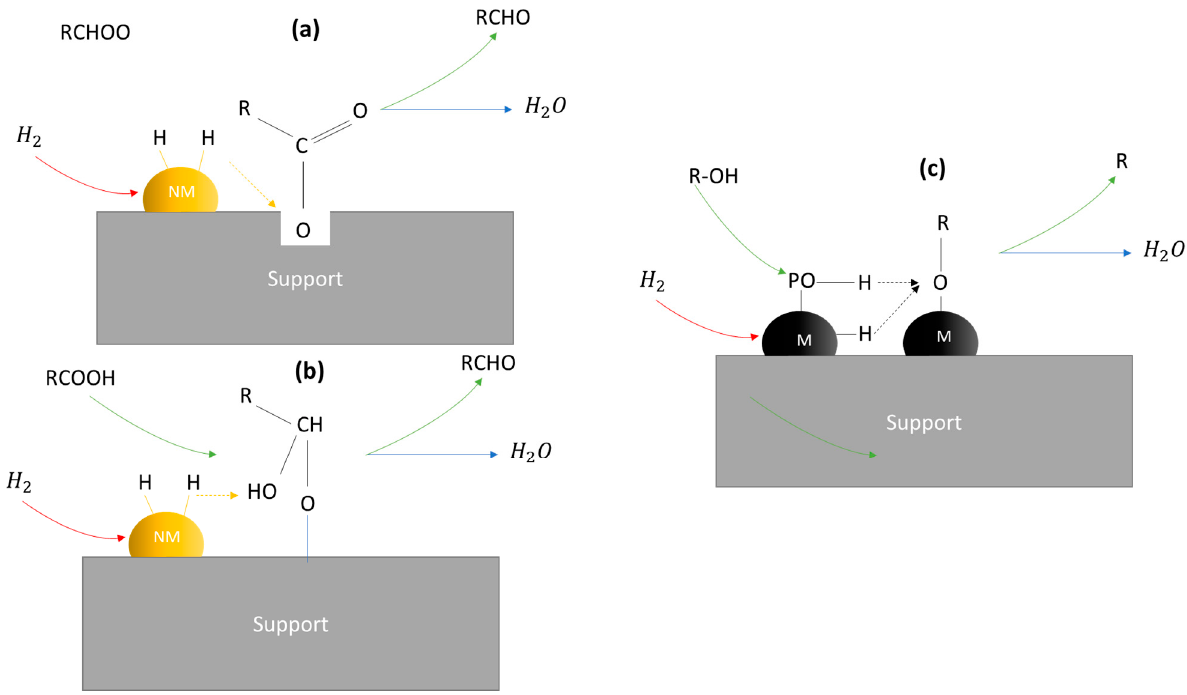
Figure 8. ( a , b ) HDO mechanisms over noble metal (NM) supported catalysts. Adapted from Refs [135,136]. ( c ) Proposed HDO mechanisms over TMPs catalysts. Adapted from Refs [137,138], M stands for